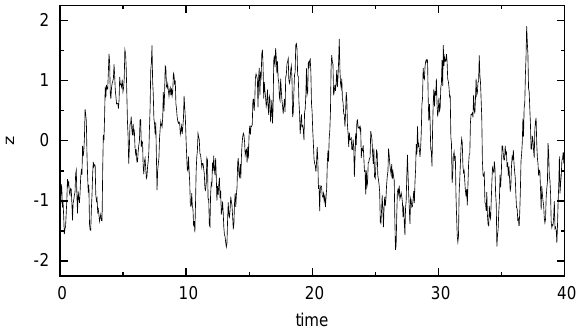
Fig. 1. Sample trajectory of z in the oscillator with symmetric